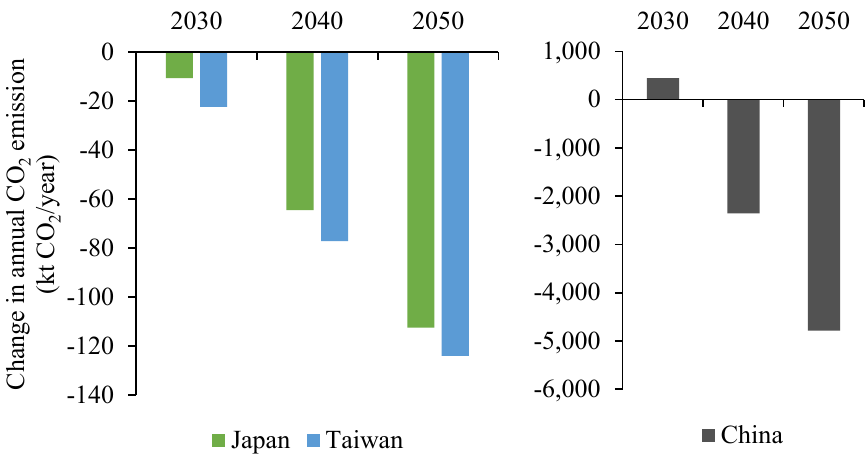
Figure 17. Total change in annual CO 2 emissions after electrification of the dyeing process.